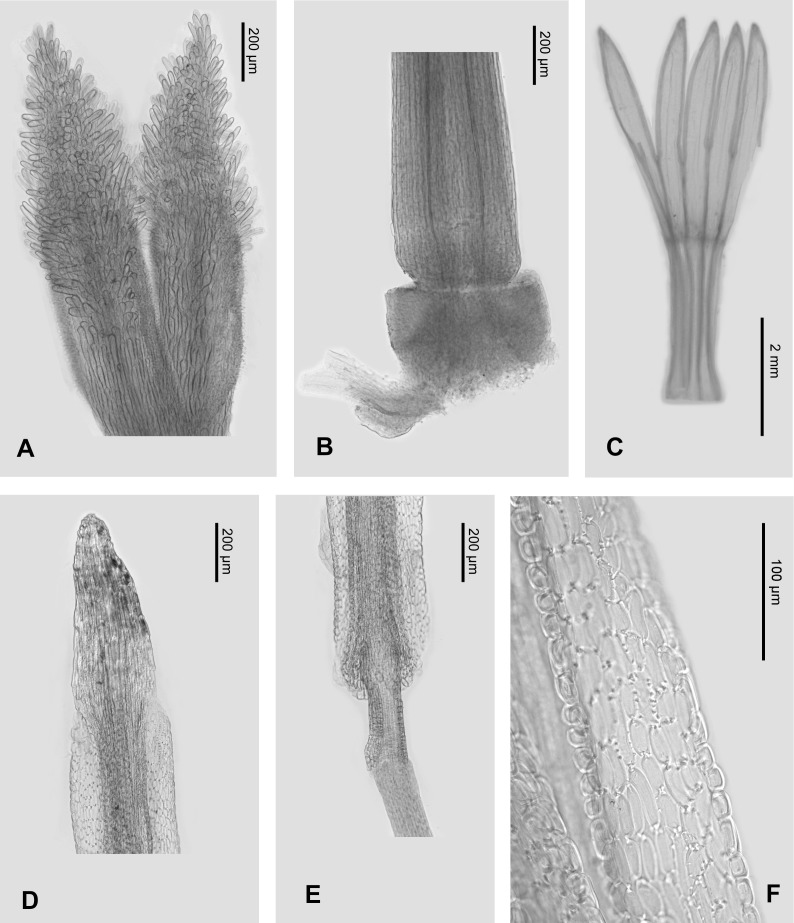
Micro-morphology of Aster tonglingensis.(A) Style branches; (B) stylopodium; (C) corolla; (D) anther tip appendage; (E) anther base appendage, filament collar and anther endothecial tissue.